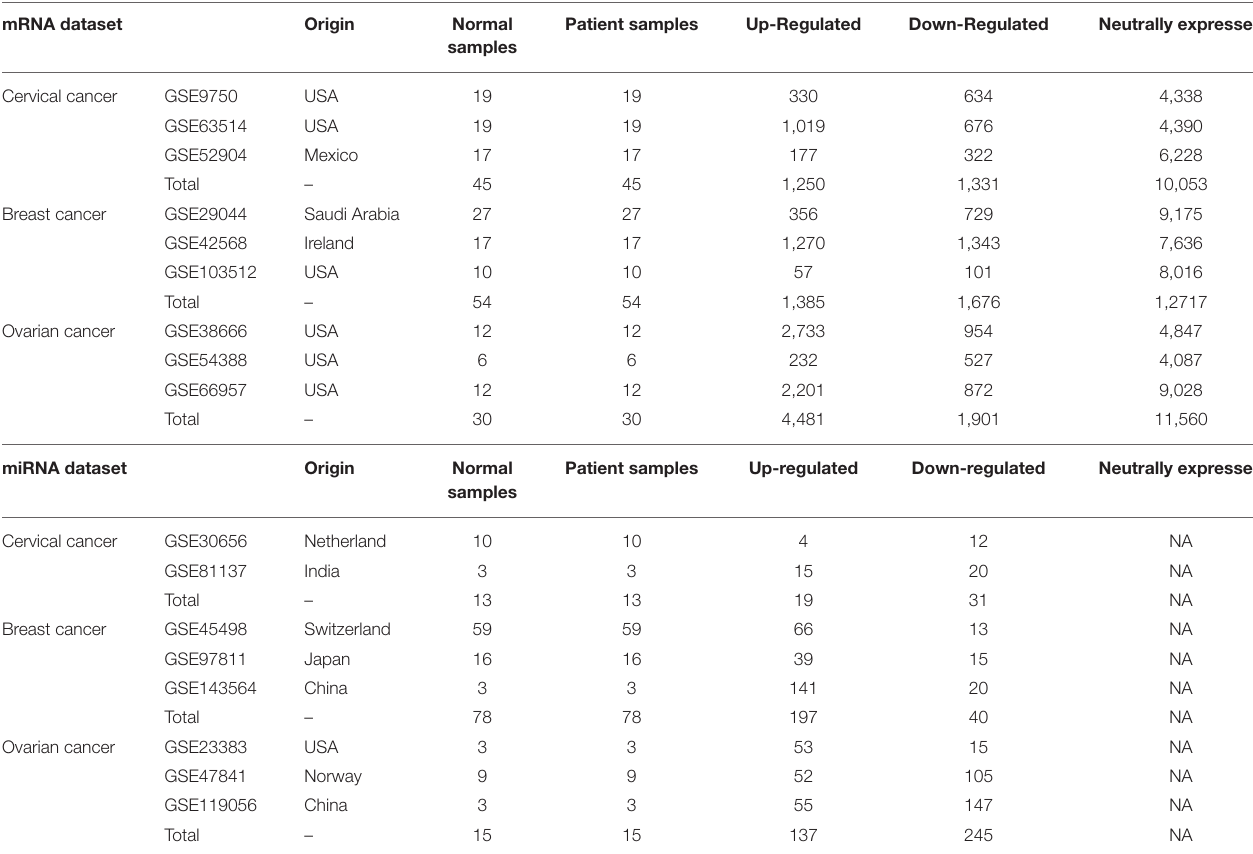
Patient samples Up-Regulated Down-Regulated Neutrally expressed samples